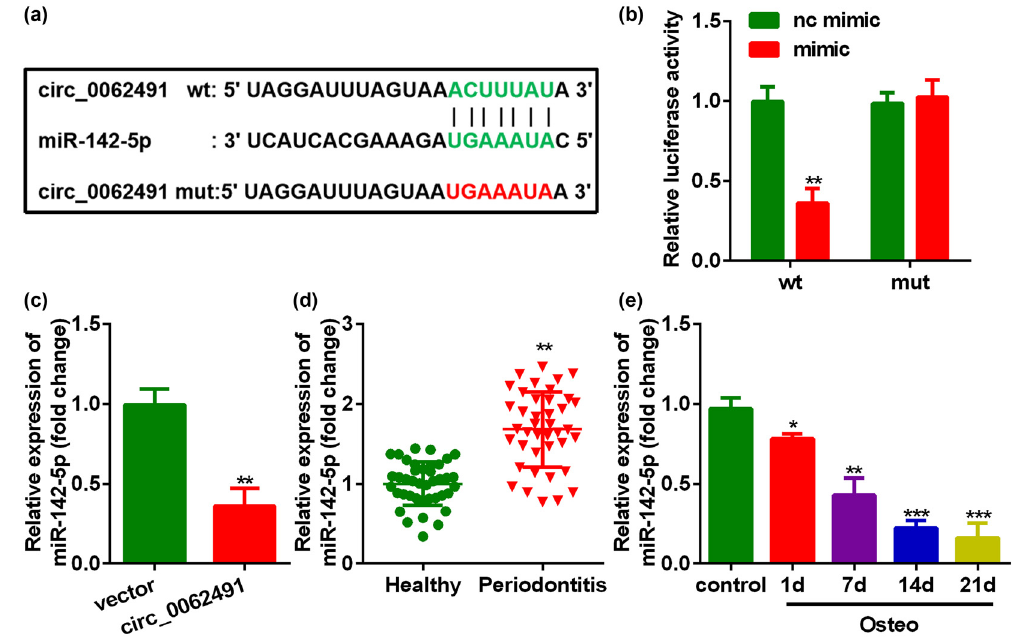
Figure 3: circ_0062491 targeted miR - 142 - 5p in PDLSCs. ( a ) Bioinformatics predicted the binding sites between miR - 142 - 5p and circ_0062491. ( b ) Dual - luciferase reporter assay con fi rmed that miR - 142 - 5p was a target of circ_0062491 in PDLSCs. ( c – e ) qRT - PCR analysis was performed to detect the expression of miR - 142 - 5p in PDL tissues and PDLSCs. * p < 0.05, ** p < 0.01, *** p < 0.001. vs nc mimic, vector, healthy and control group.